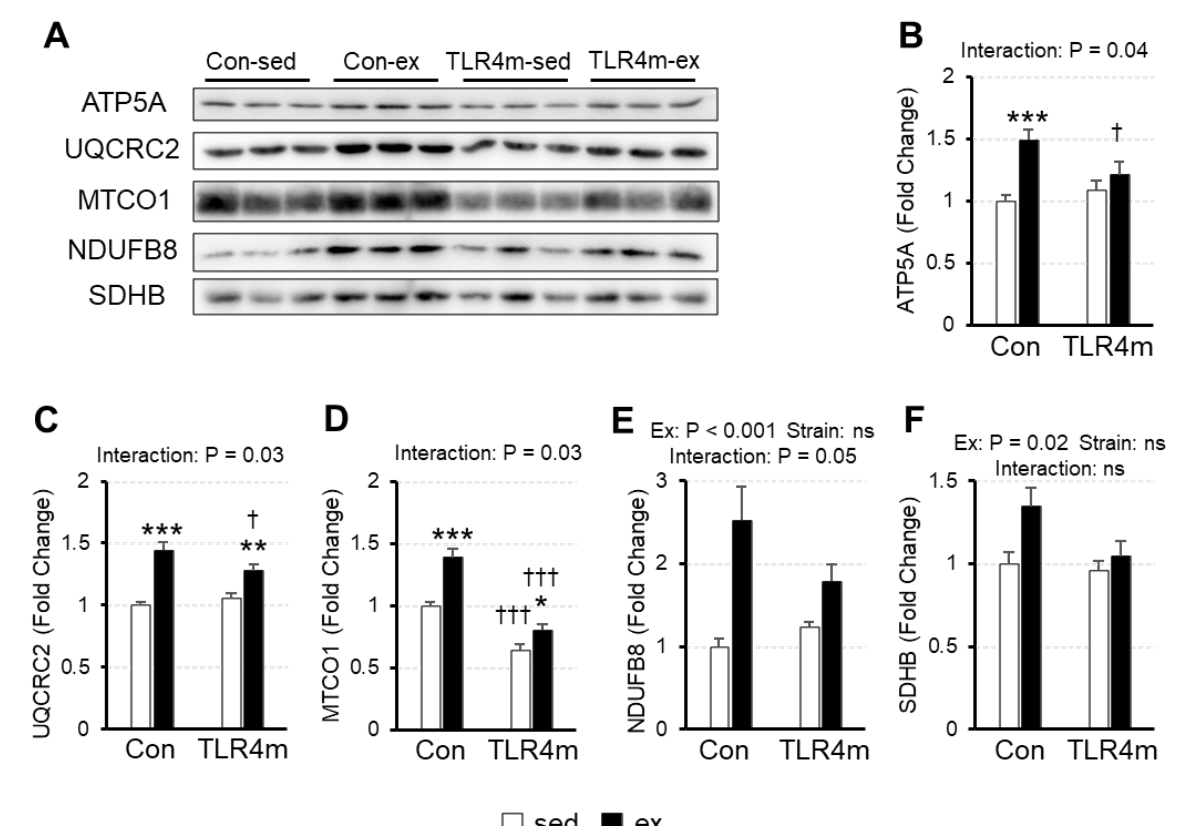
Figure 3. The relative expressions of mitochondrial oxidative phosphorylation proteins in plantaris. ATP synthase subunit alpha (ATP5A) ( B ), cytochrome b-c1 complex subunit 2 (UQCRC2) ( C ), mitochondrial cytochrome c oxidase 1 (MTCO1) ( D ), NADH dehydrogenase [ubiquinone] 1 beta sub-complex subunit 8 (NDUFB8) ( E ), and succinate dehydrogenase [ubiquinone] iron-sulfur subunit (SDHB) ( F ) were measured. Representative images of immunoblots are shown ( A ). Values are means ± standard error; n = 6 per group. Fold changes are expressed relative to the level of the Con sed group. *** p < 0.001, ** p < 0.01, and * p < 0.05 vs. sed within each strain; ††† p < 0.001 and † p < 0.05 vs. controls within each condition .